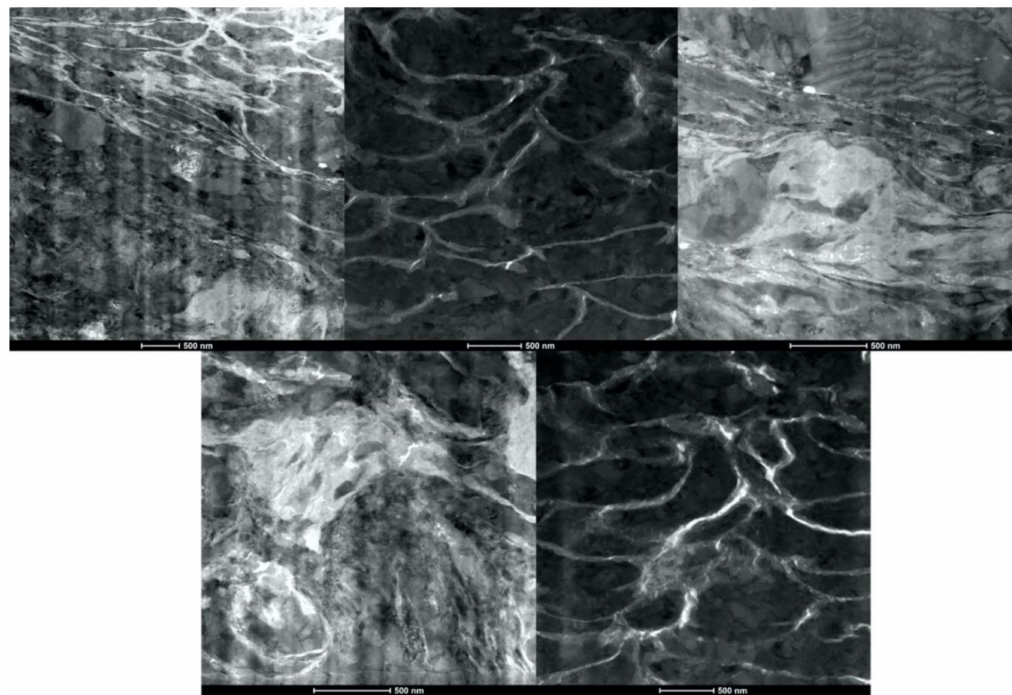
Figure 19. STEM micrographs of the deformed microstructure of the nanostructured cold sprayed coatings in the cross-sectional orientation. The scale bar represents 500 nm.